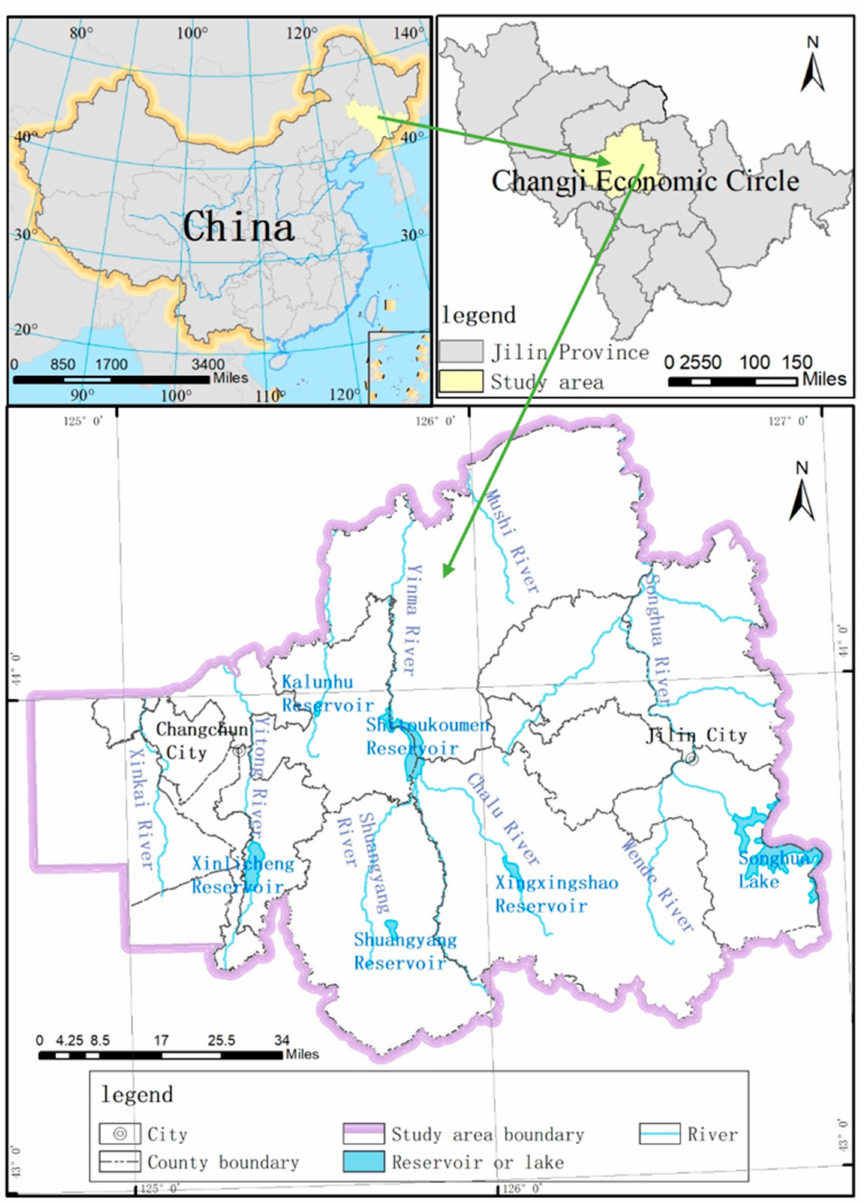
Figure 1. The location of the study area and the distribution of the river system and the water